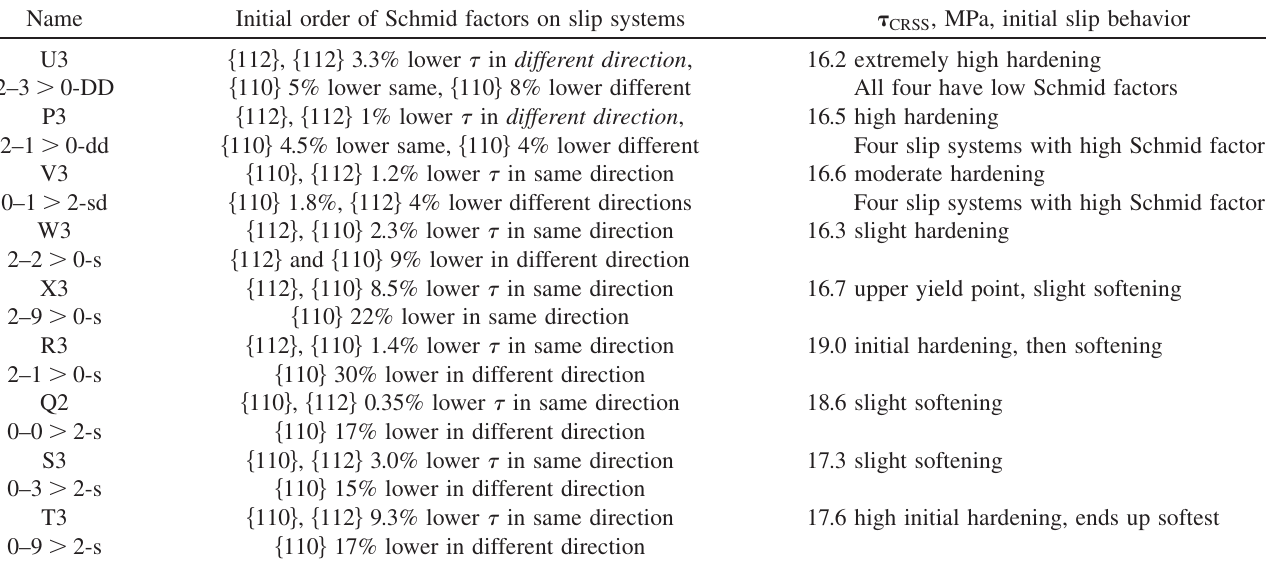
TABLE I. Intended slip system activation in single-crystal tensile specimens from Ningxia ingot slice. Name Initial order of Schmid factors on slip